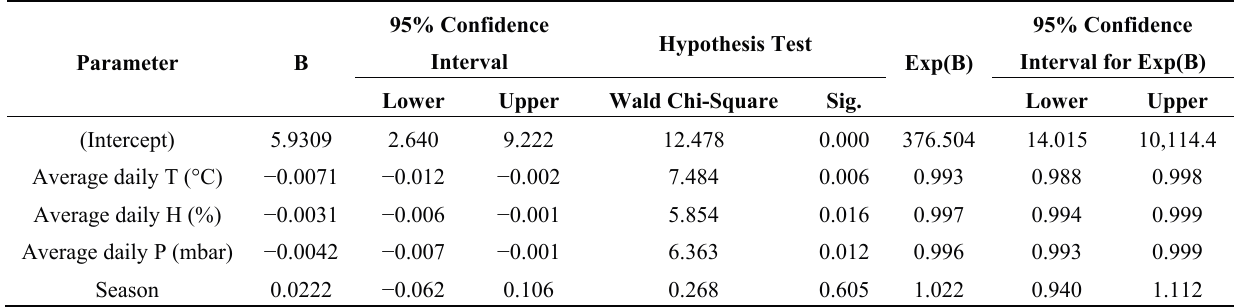
Table 1. Daily ACS incidence for the entire population.